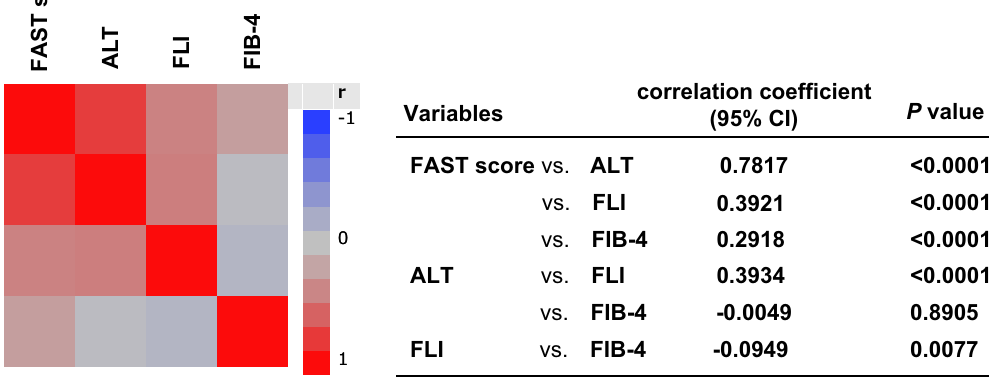
Figure 2. Color map showing the correlations among the FAST score, ALT level, and noninvasive test results for patients with MAFLD. ALT: alanine aminotransferase; FAST: FibroScan-aspartate aminotransferase; FLI: fatty liver index; FIB-4: Fibrosis-4; MAFLD: metabolic-associated fatty liver disease; CI: confidence